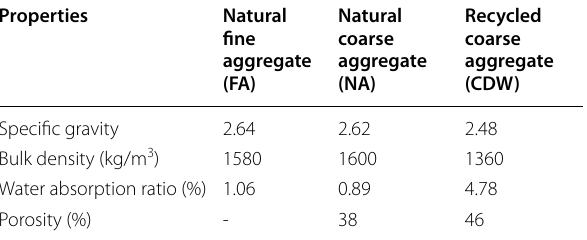
Table 1 Properties of natural and recycled aggregate Properties